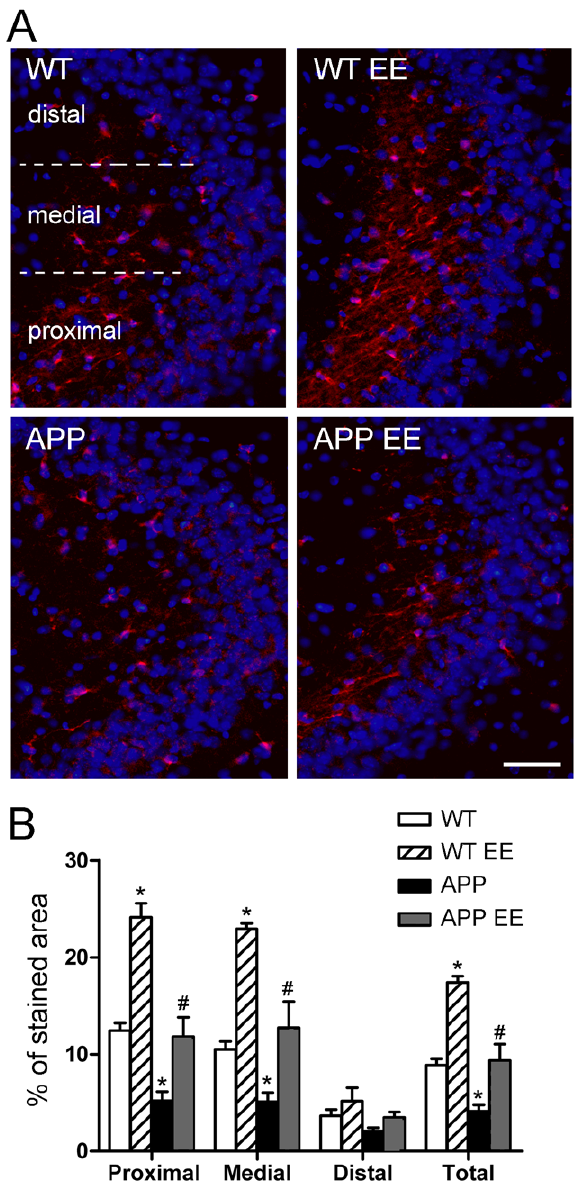
Figure 5. Density of doublecortin-positive fibers in CA3 hippocampal region of control and APP Sw,Ind mice. (A) Repre- sentative epifluorescence microscopy images of the stratum lucidum stained for doublecortin (Dcx, red) and Hoechst (blue). Scale bar =50 m m. (B). Semiquantitative analysis reveals a significant reduction in the area ocuppied by Dcx-positive fibers in the stratum lucidum of the CA3 region in APP Sw,Ind mice. Enrichment increased significantly the density of Dcx staining in the stratum lucidum in both WT and APP Sw,Ind mice compared to standard housed mice. Data represent mean 6 SEM. *p , 0.01, compared to WT mice. # p , 0.01, compared to APP Sw,Ind mice. Number of mice/group: 6.